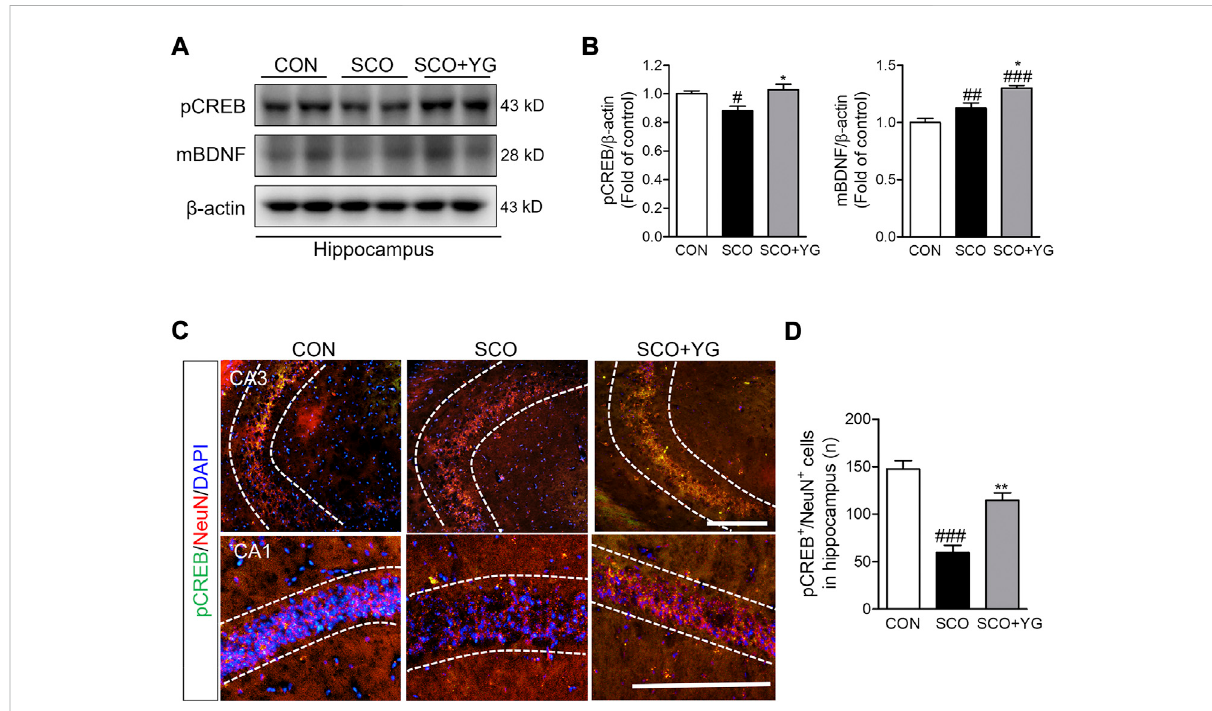
FIGURE 8 YG regulate CREB/BDNF signaling in hippocampus of mice. (A) Western blot and (B) its histogram for pCREB and mBDNF. Histograms show protein relative to β -actin protein. Double-immunostaining of pCREB and NeuN in hippocampus of mice. (C) Microphotographs and (D) histogram for pCREB and NeuN in the CA1 and 3 regions. All data are presented as the mean ± SEM from three independent mice. # p < 0.05, ## p < 0.01, ### p < 0.001 vs. CON; * p < 0.05, ** p < 0.01 vs. SCO by ANOVA with Newman-keuls post-hoc analysis. Scale bar = 200 μ m. CON; control,